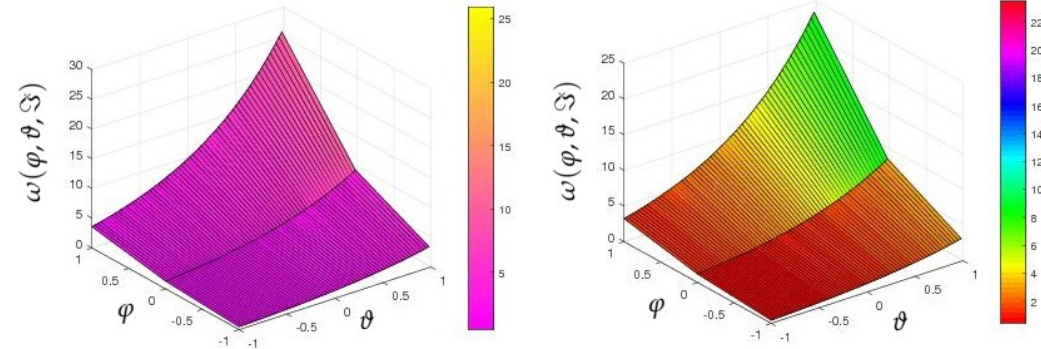
Figure 8. The HPTM graphs of δ = 0.6 and 0.4 of ω ( ϕ , ϑ ) , Example 1.